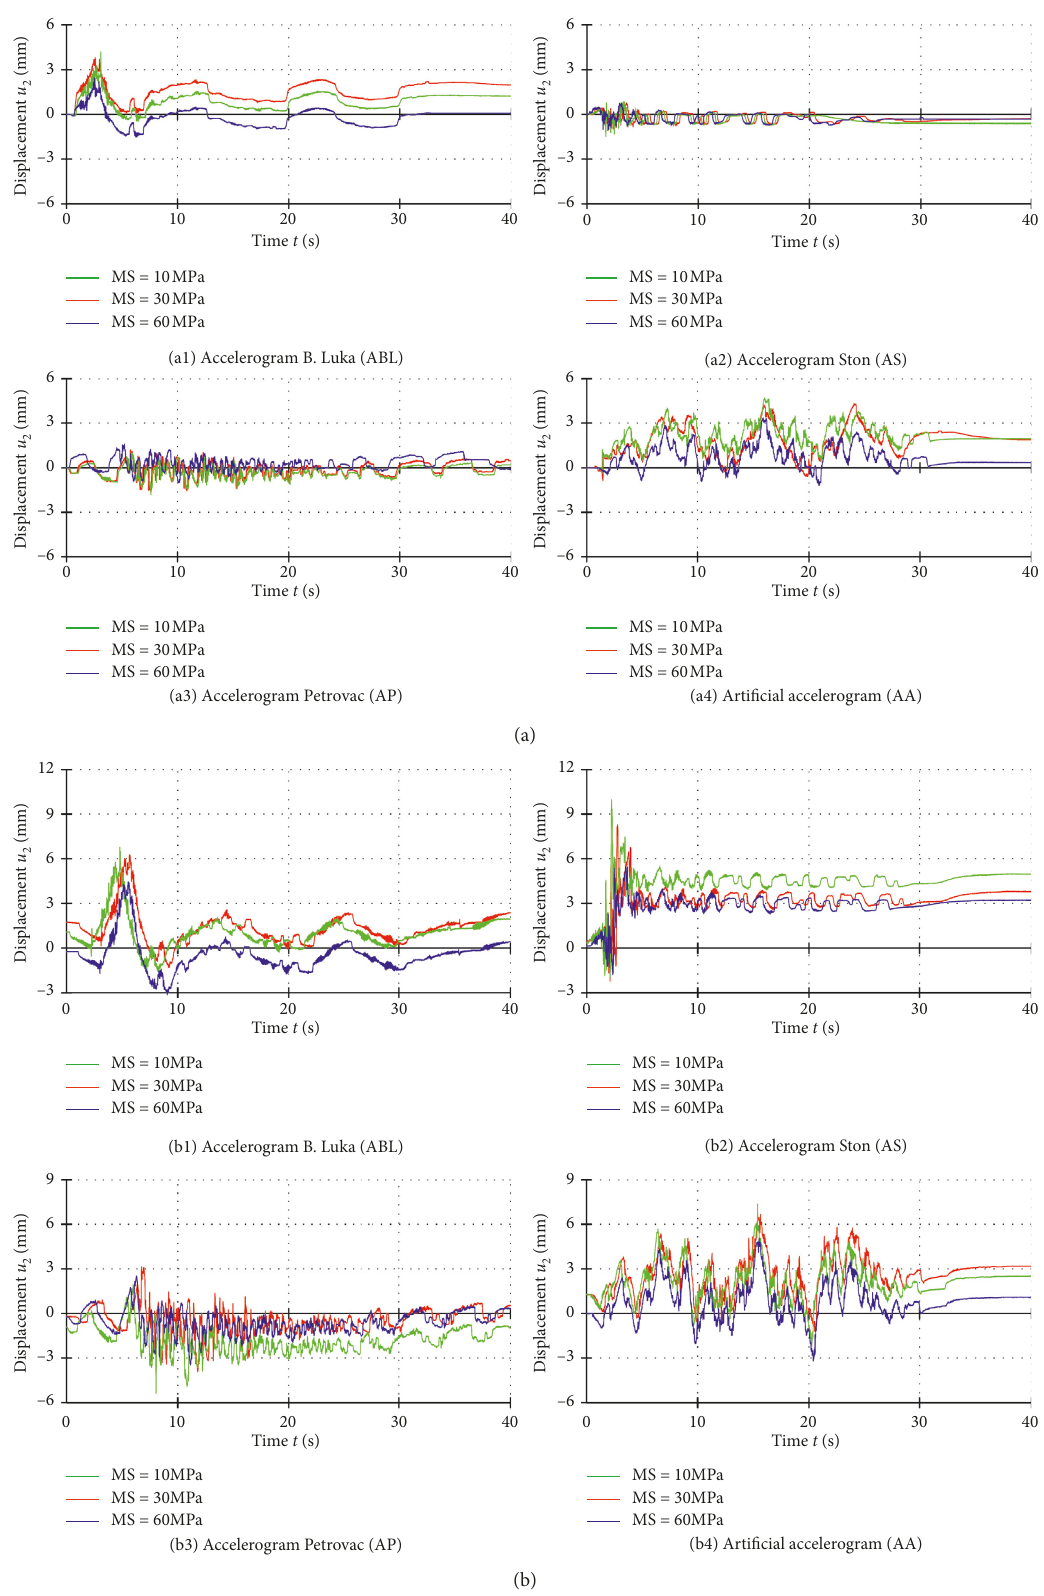
Figure 18: The effect of pebble layer compaction on horizontal displacement u